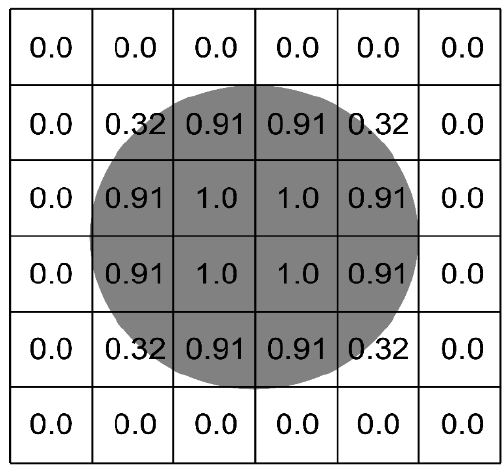
Figure 1. Eulerian volume fraction.